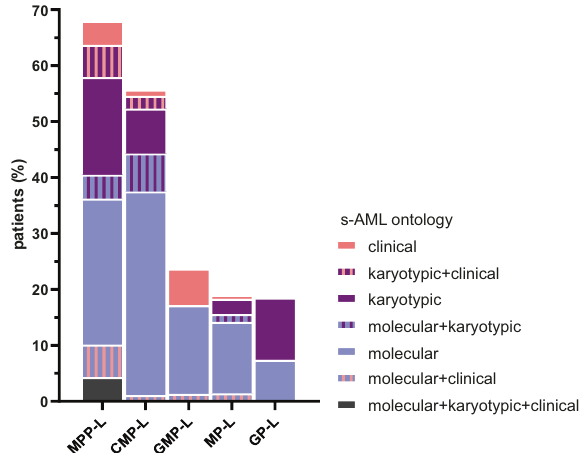
Fig. 5 Secondary AML according to the SLA. De fi nition of secondary AML in 409 patients based on an association of clinical (history of MDS or MPN), molecular (mutations in any of the eight genes frequently altered in MDS [37]) and/or karyotypic abnormal- ities as de fi ned by